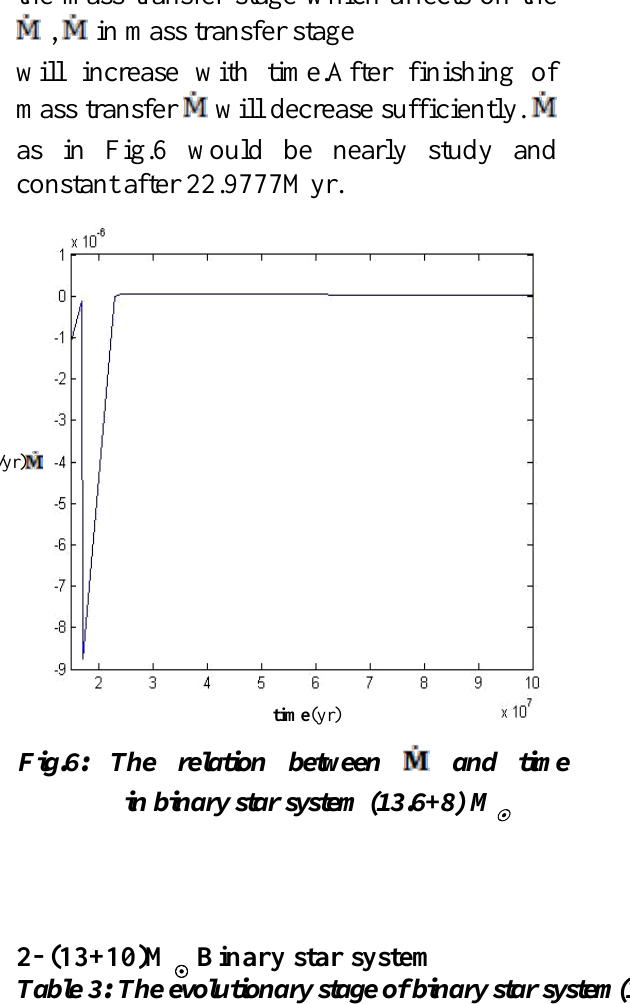
Table 3: The evolutionary stage of binary star system(13+10)M Time